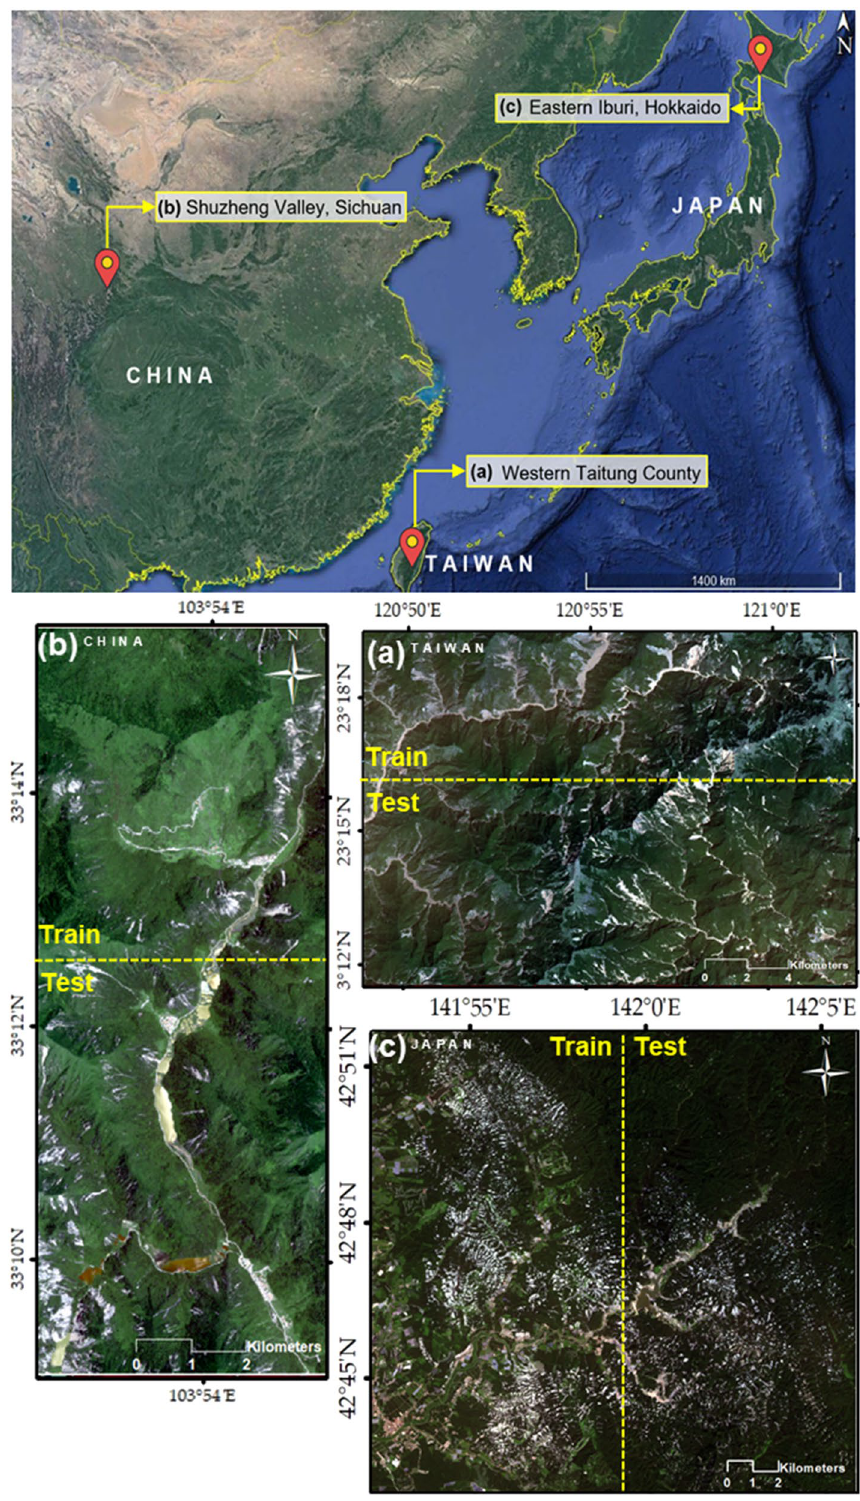
Figure 1. Overview of the study areas: ( a ) Shuzheng Valley (China); ( b ) Western Taitung County (Taiwan); and ( c ) Eastern Iburi (Japan). The training and testing areas are presented on Sentinel-2 images, band combination 1–2–3 (https:// scihub. coper nicus. eu/). The upper figure was drawing based on Google Earth and ( a ), ( b ), and ( c ) were generated with the ArcMap v.10.8 software (https:// deskt op. arcgis. com/ es/